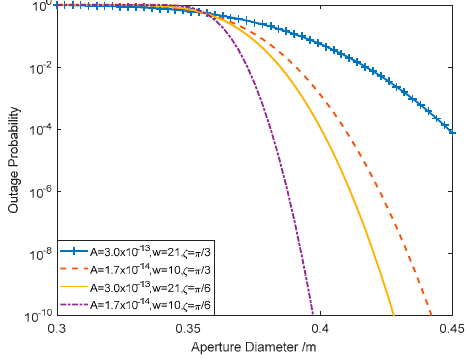
Figure 3. Performance of outage probability when the aperture area is variable.